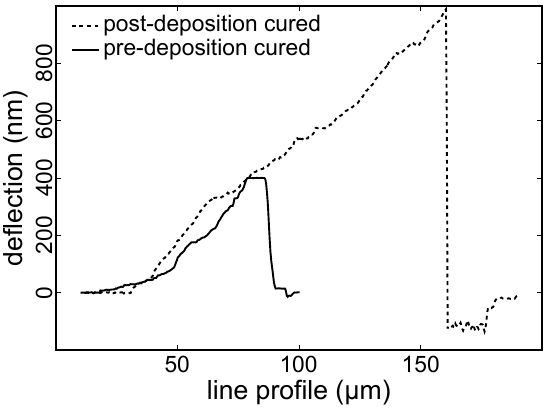
Figure 1. Line profile (perpendicular to the fast scan direction) across the deflection